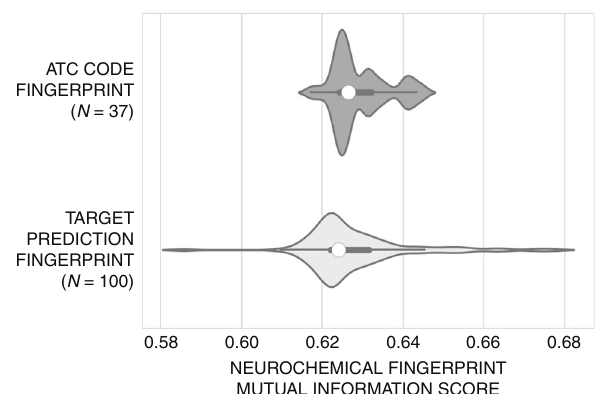
(Fig. 8a) and the fi ve protein targets providing the highest mutual